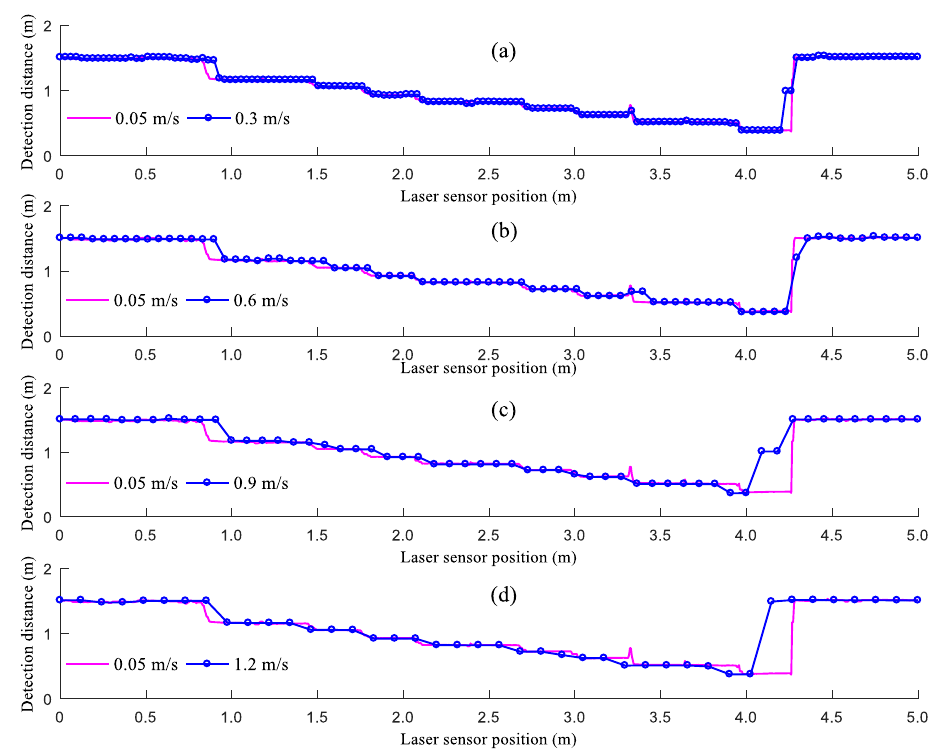
Figure 8. Results of the step detection experiment across a speed gradient: ( a ) 0.3 m/s; ( b ) 0.6 m/s; ( c ) 0.9 m/s; ( d ) 1.2 m/s.